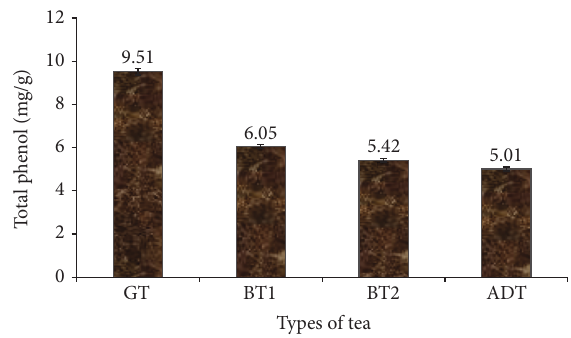
Figure 2: Total phenol content of some commercially available tea.